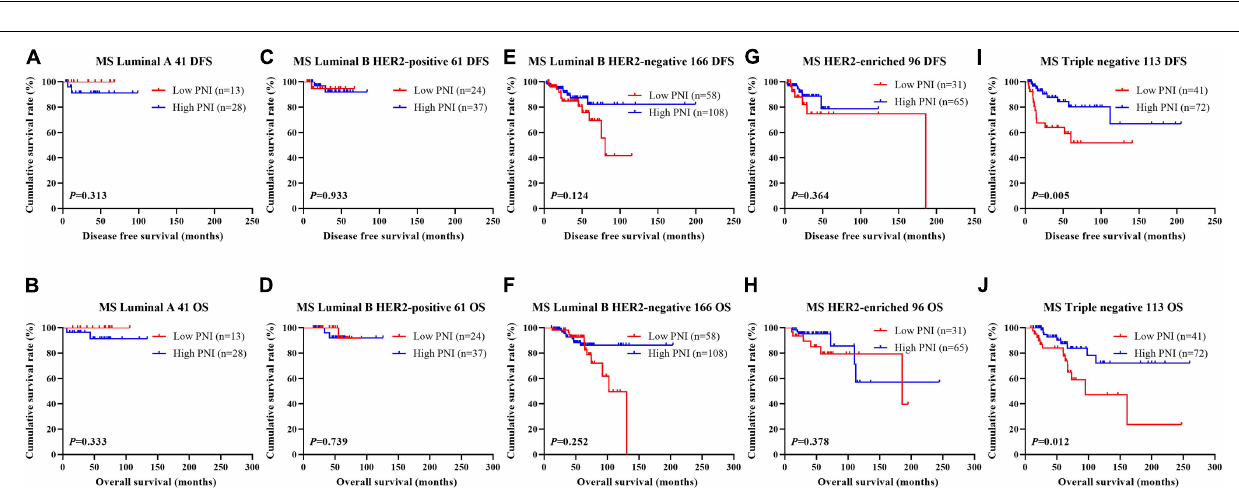
was divided into without lymph vessel invasion and